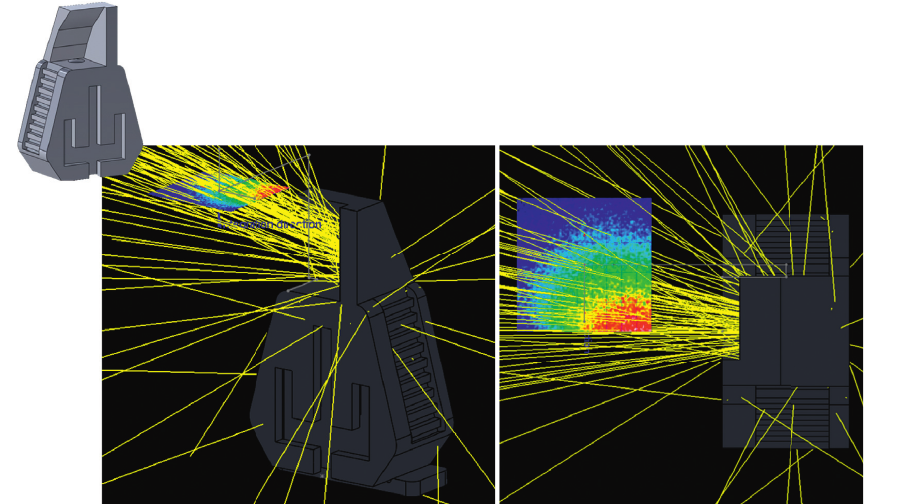
Figure 11: Optical analog light trace of geometric bevel angle